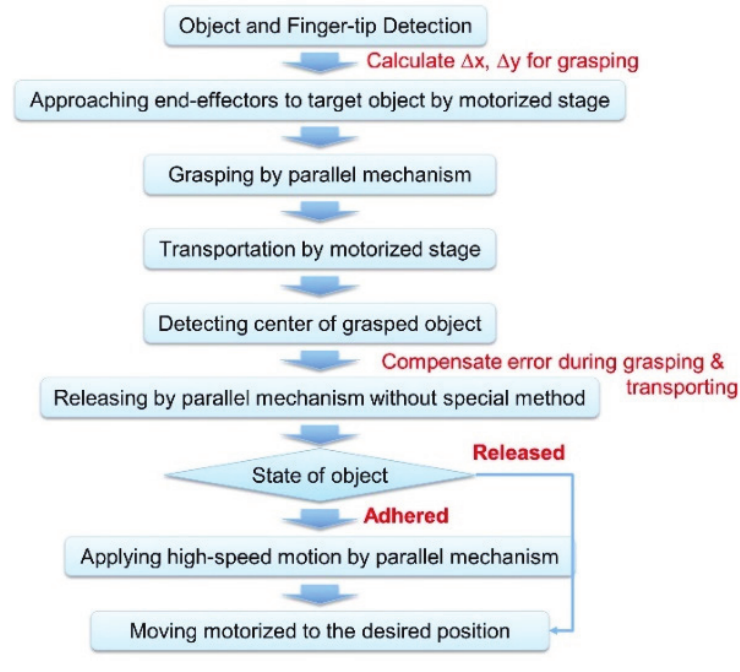
Figure 2. Manipulation process of an object.